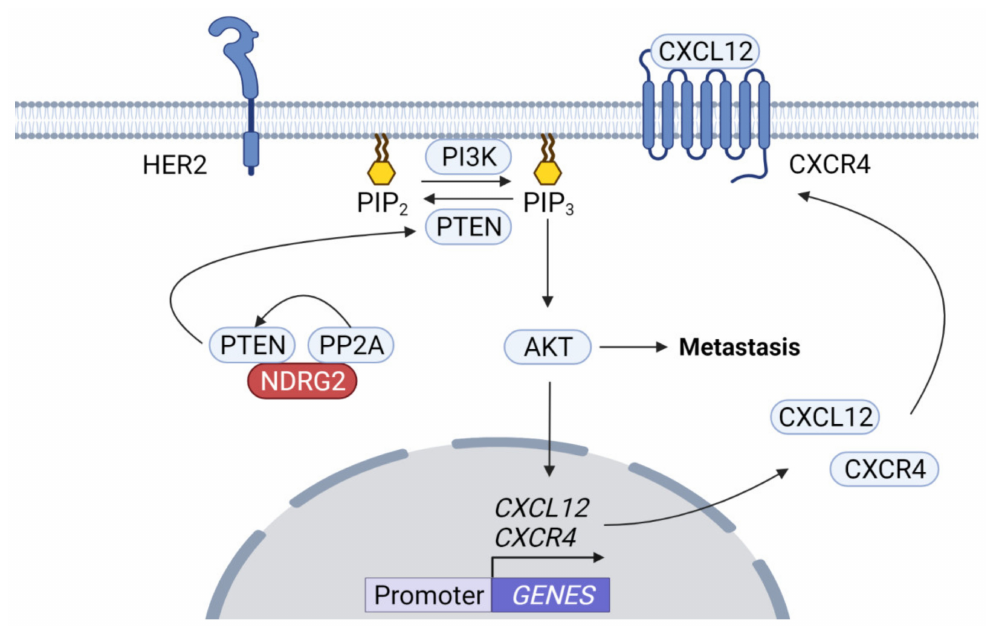
Figure 1. AKT inhibition by the NDRG2–PP2A complex. HER2 activates PI3K/AKT signaling. PTEN is a dual protein/lipid phosphatase using phosphatidylinositol, 3,4,5 triphosphate (PIP3), a product of PI3K, as a substrate. An increase in PIP3 recruits AKT to the membrane, which is activated by other PIP3-dependent kinases. NDRG2 acts as a bridge mediating the interaction between PP2A and PTEN, thus the NDRG2–PP2A complex recruits PTEN and triggers its activation. PTEN can inhibit AKT activity by inducing dephosphorylation of PIP3, thereby inhibiting AKT-dependent tumor cell